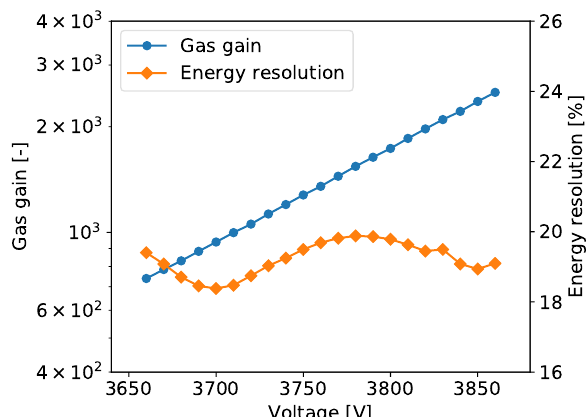
Figure 5. GEM detector A 2 . Gas gain and energy resolution vs. detector bias voltage.